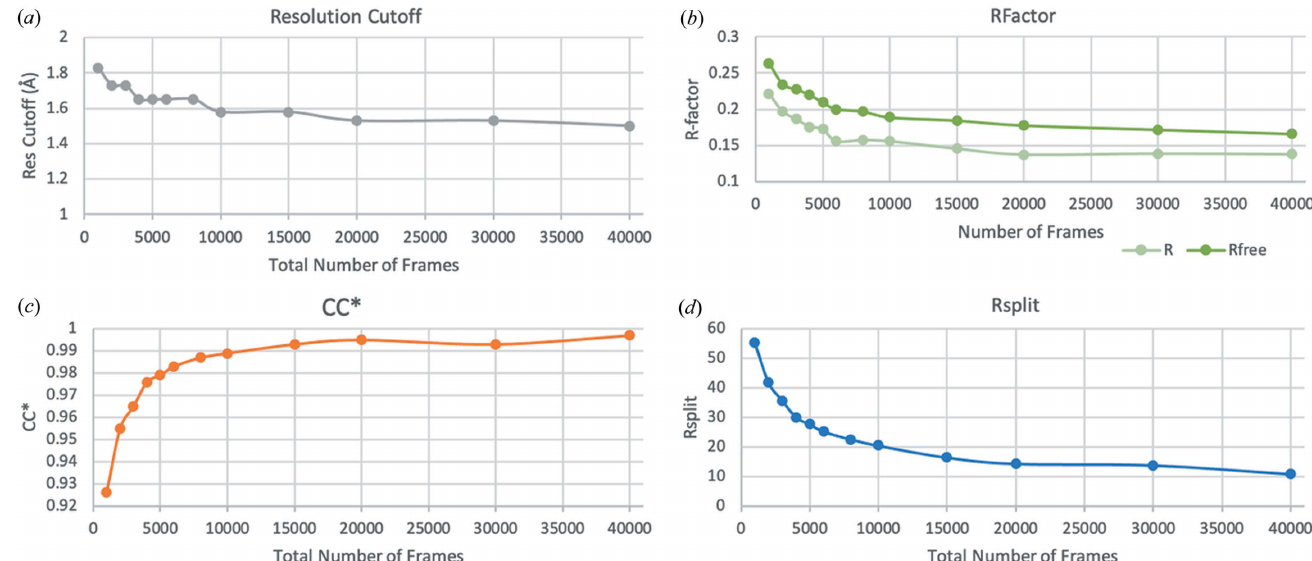
Figure 4 Evolution of crystallographic and refinement metrics for NhGH11 as a function of the number of detector frames included in a dataset. ( a ) Evolution of resolution cut-off (resolution at which CC* > 0.5) as a function of addition of further detector frames. ( b ) Evolution R work and R free values using the same starting model and refinement parameters and high-resolution cut-off of 1.9 A˚ . ( c ) Overall CC* and ( d ) overall R split values as a function of detector frames added, calculated to a high-resolution cut-off of 1.8 A˚ .